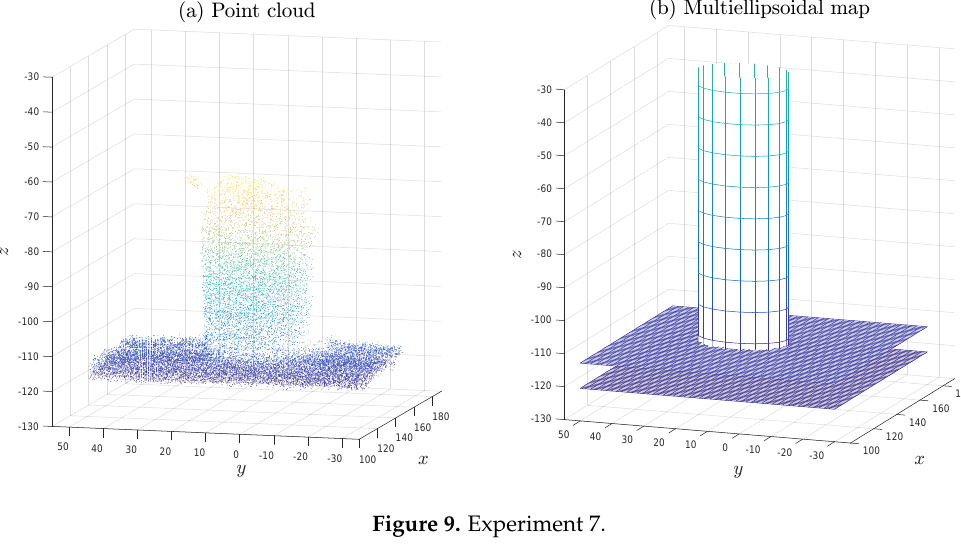
Figure 9. Experiment 7.